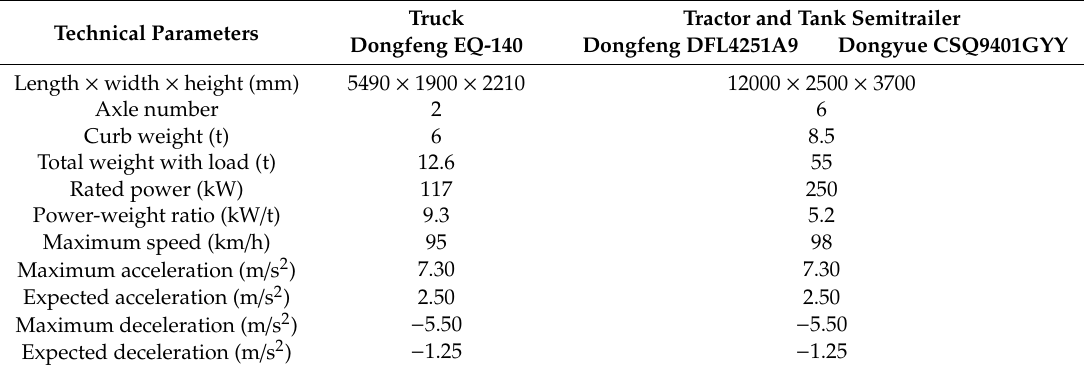
Table 2. Main technical parameters of the truck